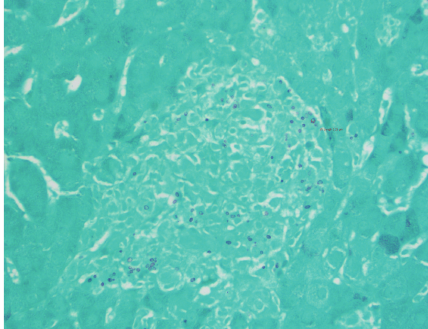
Figure 1: Liver tissue with Grocott’s methenamine silver stains (GMS) showing round to ovoid 2–4 micrometers narrow based budding fungal